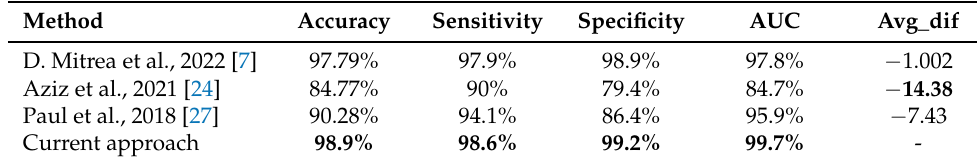
Table 8. Comparisons with other relevant state-of-the-art approaches.